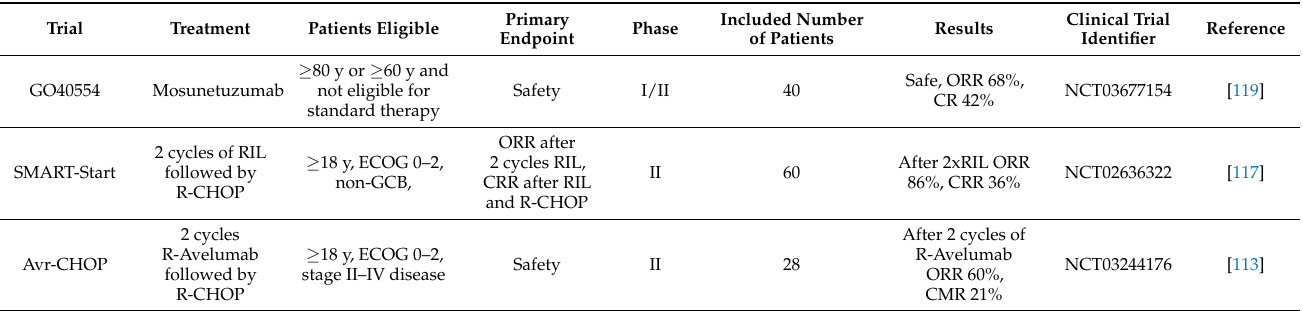
Table 2. Chemotherapy-free induction therapy regimens in